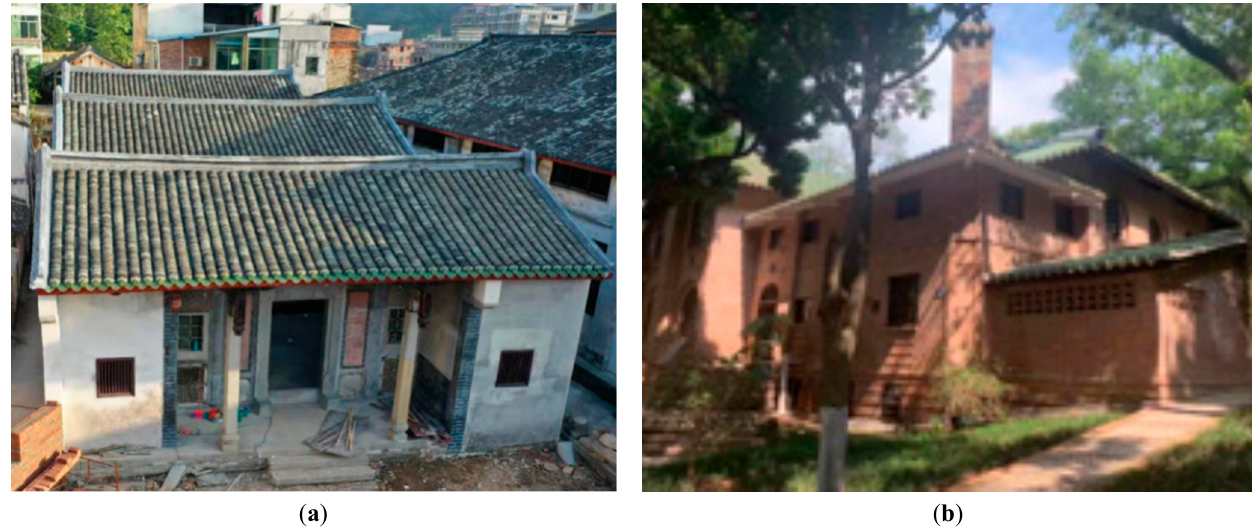
Figure 8. Historical sites for digital documentation in Guangdong, China: ( a ) Zou Lu House; ( b ) Wesley House. Table 2. Details of the two real datasets captured for the experiment.